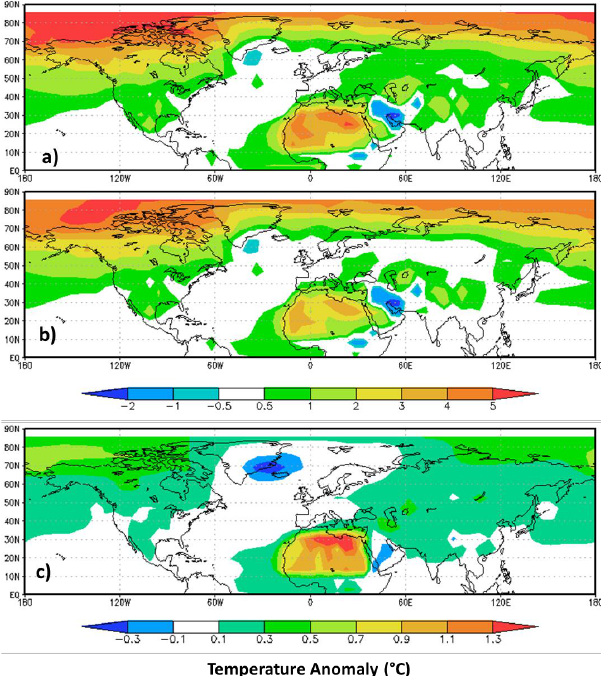
Figure 6. Temperature change between (a) 6ka Green Sahara – 0ka Sahara (with modern day clouds prescribed in both experi- ments) (6k100gEQ–0k100dEQ); (a) 6ka Green Sahara (with 6ka prescribed clouds) – 0ka Sahara (with modern days clouds pre- scribed) (6k100gEQ_clouds–0k100dEQ); and (c) Fig. 6a–b (equiv- alent to 6ka Green Sahara with prescribed clouds – 6ka Sahara with modern day